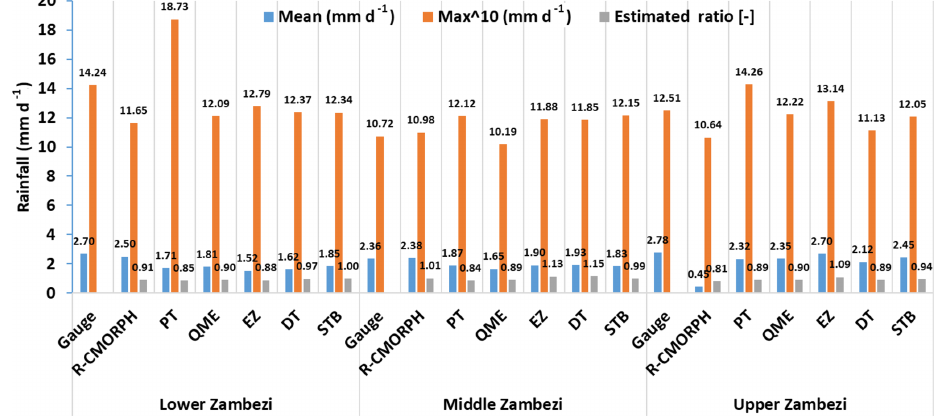
Figure 4. Frequency-based statistics (mean, max, and estimated ratio of gauged sum vs. CMORPH sum for 1999–2013) of corrected CMORPH for the Lower, Middle, and Upper Zambezi basin.